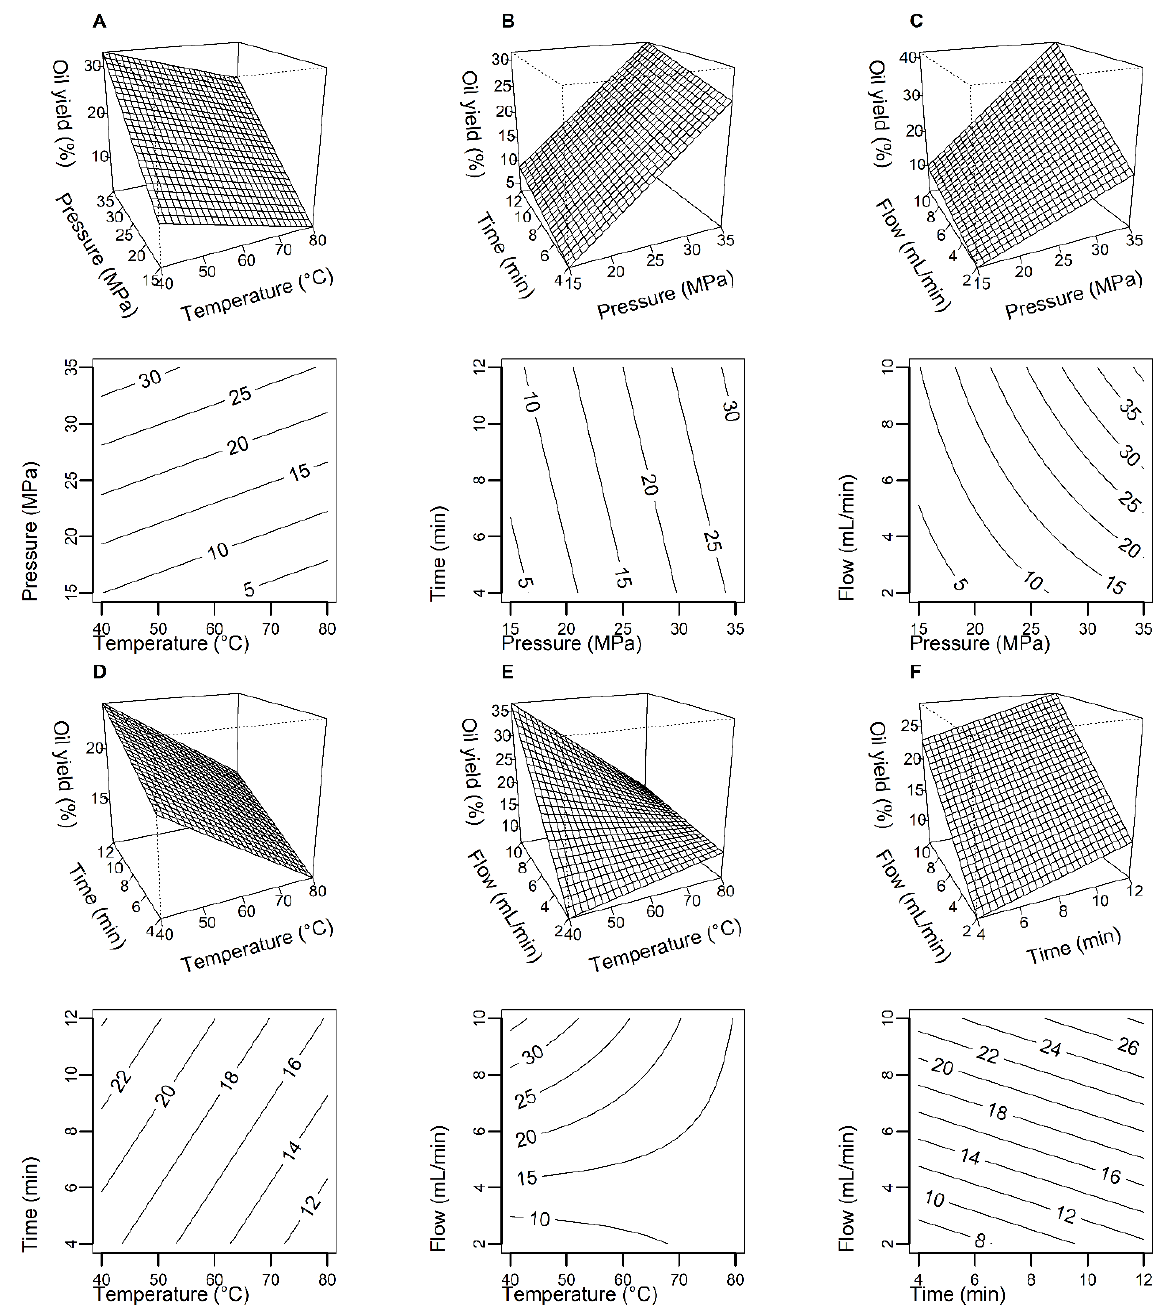
Figure 2. Response surface plots and corresponding contour plots showing the combined effect of pressure and temperature ( A ), extraction time and pressure ( B ), scCO 2 flow and pressure ( C ), extraction time and temperature ( D ), scCO 2 flow and temperature ( E ), scCO 2 flow and extraction time on N. sativa oil yield ( F ). Other variables are fixed at their respective center point (pressure: 25 MPa, temperature: 60 °C, time: 8 min, scCO 2 flow: 6 mL/min).